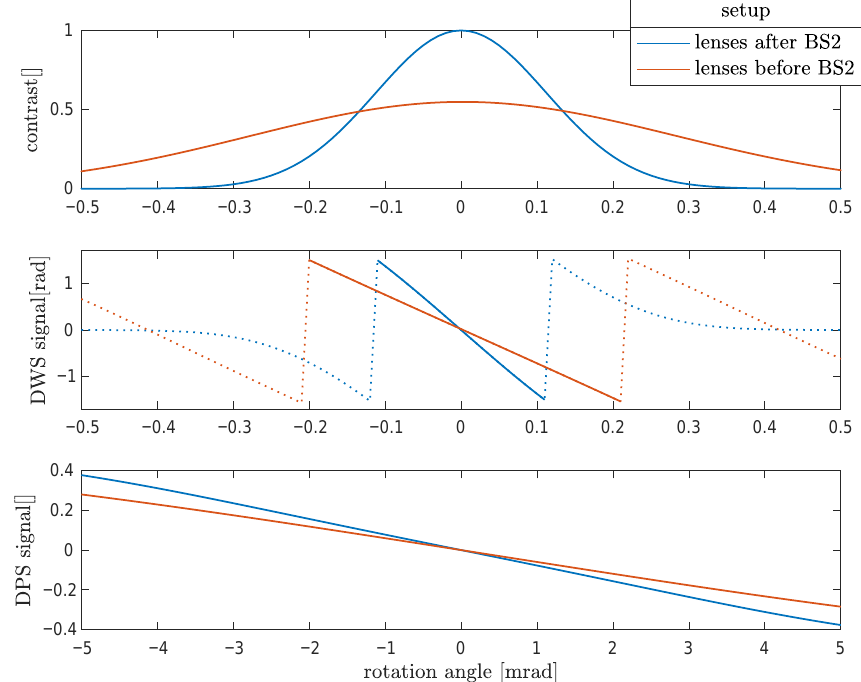
Figure 4. Interferometric signals after optimizing the setup. The setup with lenses after BS2 (blue curves) is preferred because it provides a higher contrast and more sensitive differential wave-front sensing (DWS) and differential power sensing (DPS) signals. The dotted trajectory in the DWS signal cannot be used for rotation